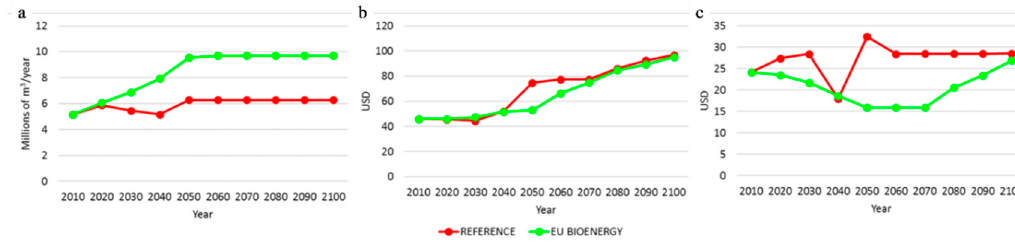
Figure 2. Some parameters of the International Institute for Applied Systems Analysis (IIASA) scenarios: ( a ) Industrial roundwood demand, total harvest, in millions of m 3 / year, under bark; ( b ) sawlog prices, national average price per m 3 (exchange rate in 2010), at the industry gate; ( c ) pulpwood prices, national average price per m 3 (exchange rate in 2010), at the industry gate.